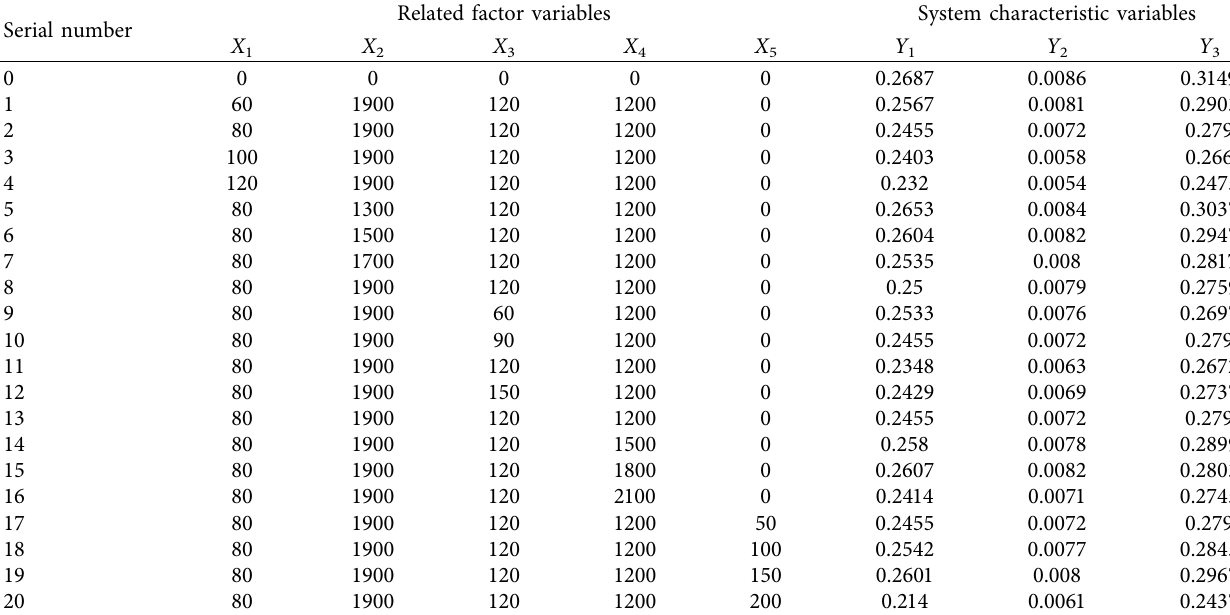
Table 6: Correlation factor variables and system characteristic variables.